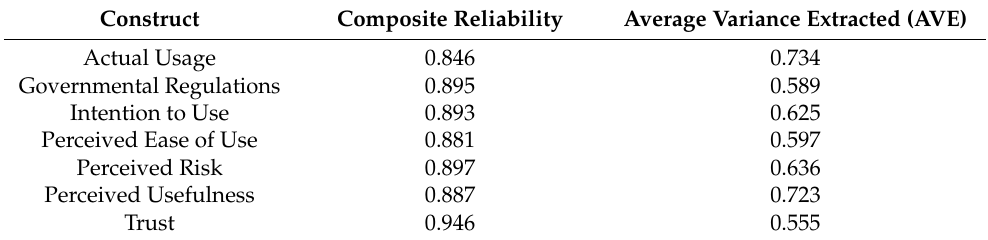
Table 1. Reliability and Validity of All Constructs.